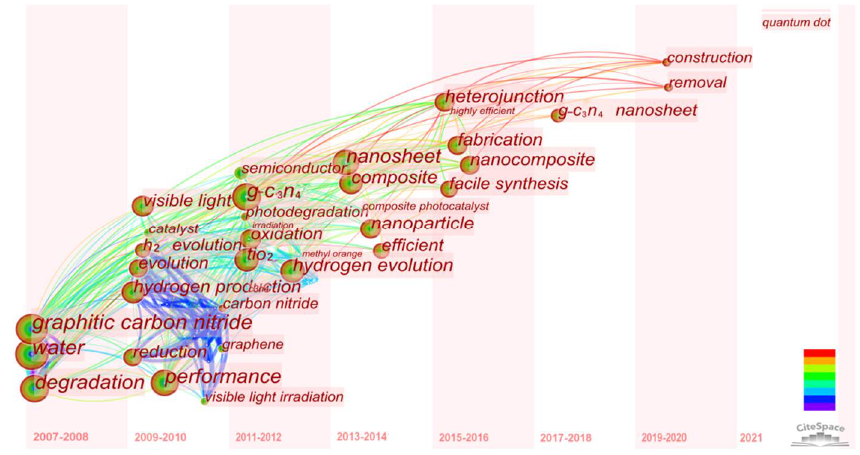
Figure 7. N etwork of keyword co-occurrence time zones. Figure 7. Network of keyword co-occurrence time